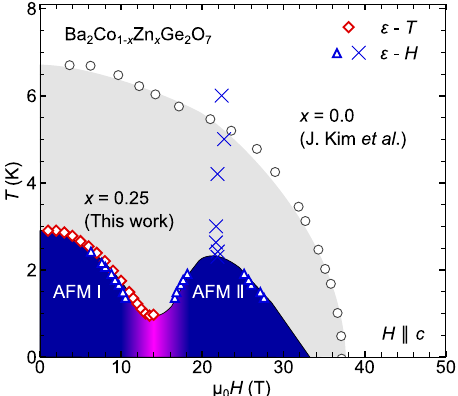
Fig. 4 | Magnetic phase diagrams of BCZGO. The points represented by blue markers are determined by the ε – H measurements in a pulsed magnetic- fi eld [Fig. 3e], while those shown by red markers are obtained from the ε – T measure- ments in a persistent magnetic- fi eld data shown in Fig. 5a. The black open circles correspond to the phase boundary of pristine Ba 2 CoGe 2 O 7 , which are collected from ref. 22